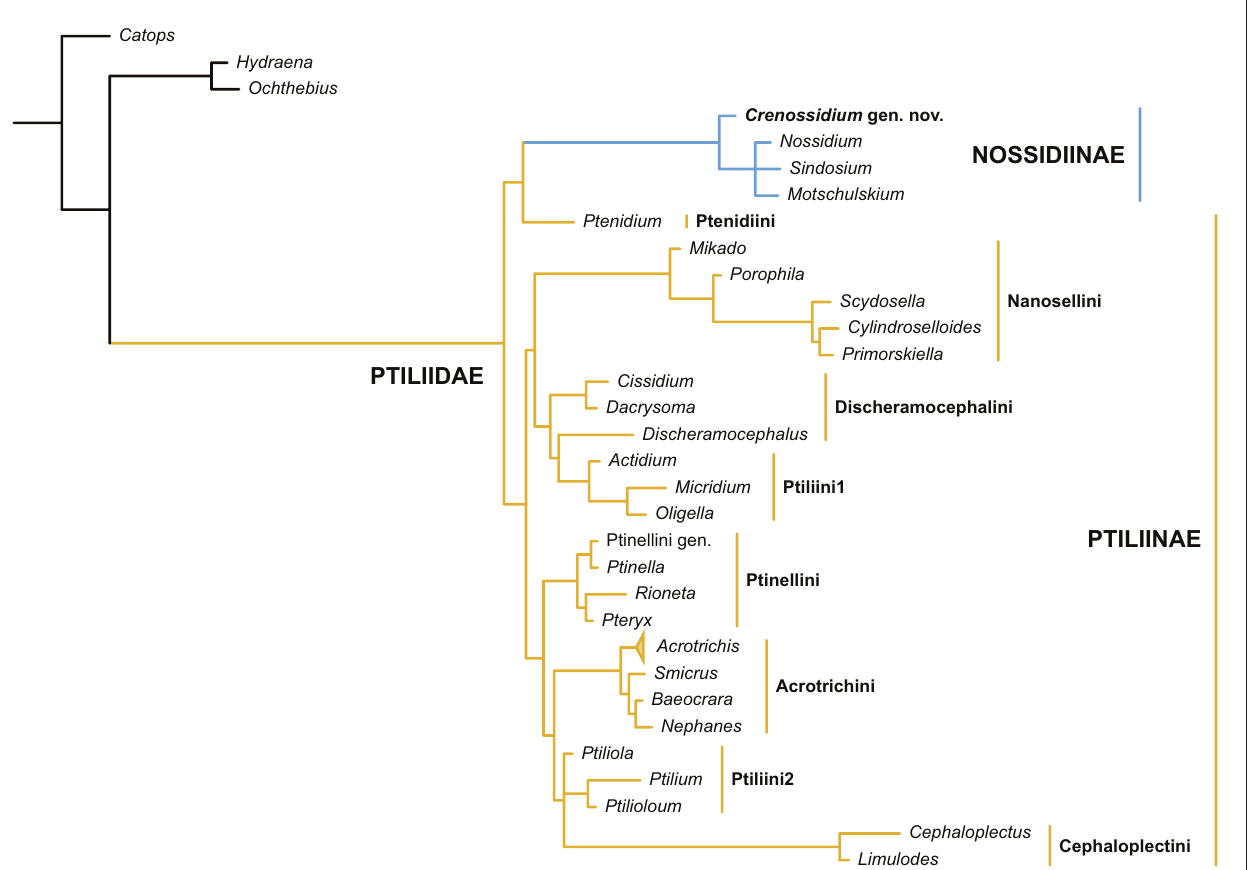
FIGURE 5 | Suggested placement of Crenossidium slipinskii Li, Newton and Cai gen. et sp. nov. within Ptiliidae. Tree resulting from the Bayesian analysis constrained by a molecular backbone